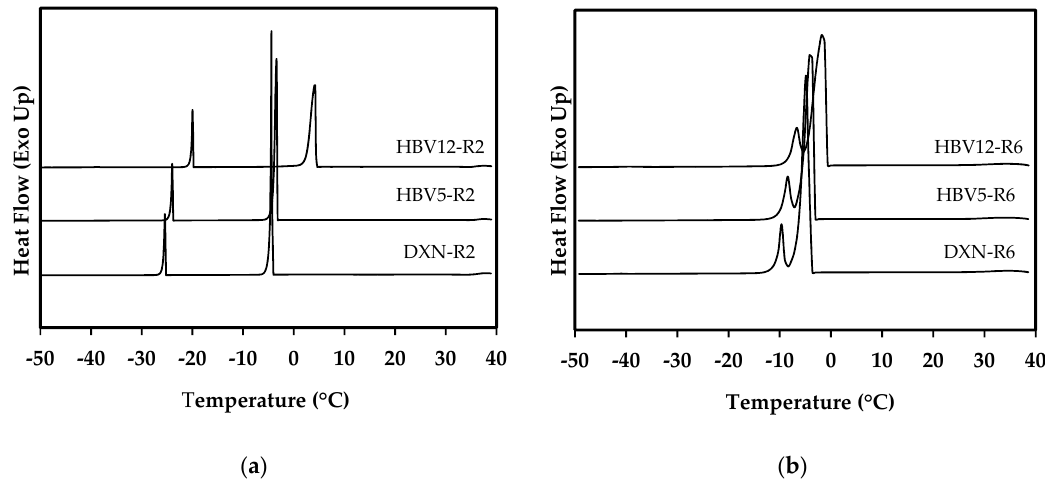
Figure 1. Exothermic peaks observed in the DSC cooling traces of the pure solvent and the two studied copolymer solution samples. Scans were performed at rates of 2 °C/min ( a ) and 6 °C/min ( b ).